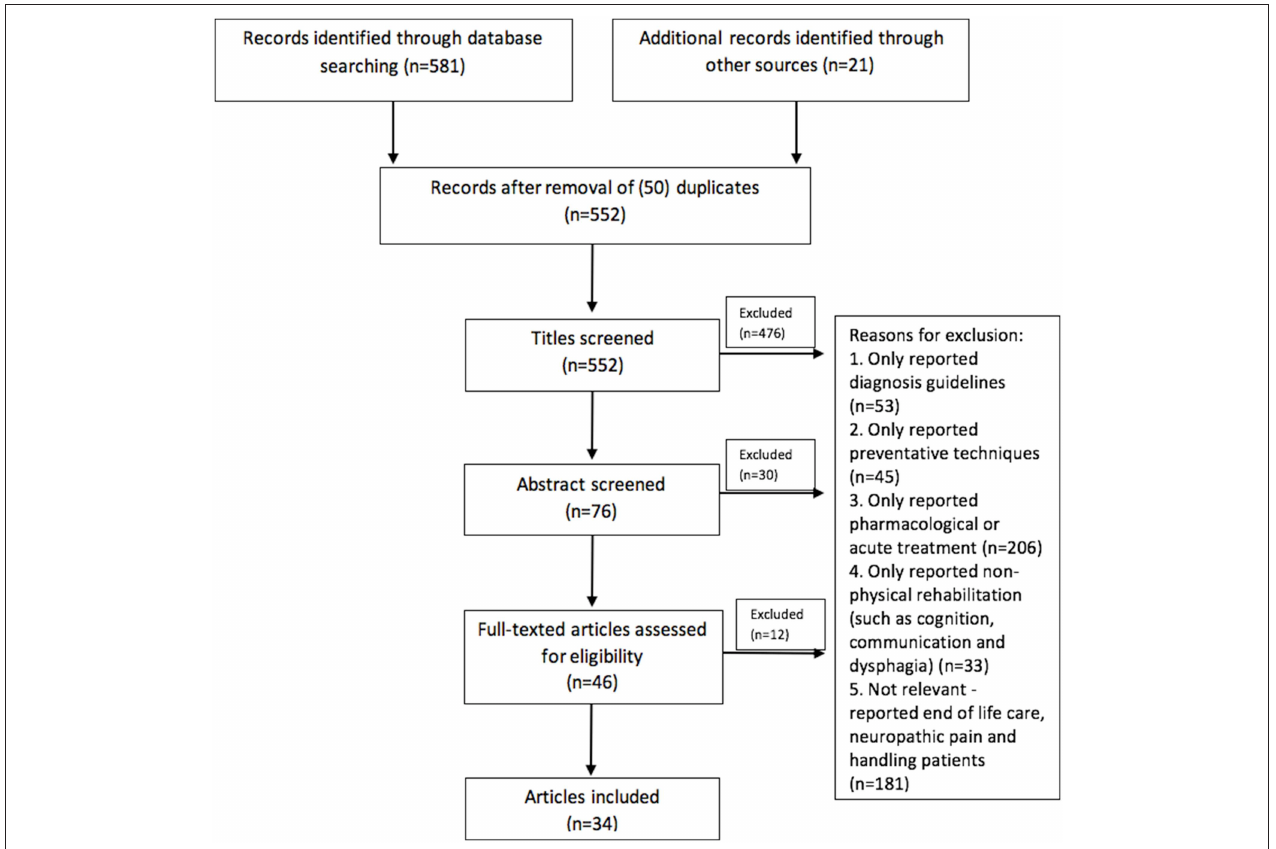
FIGURE 1 | Flow diagram of the studies retrieved for the